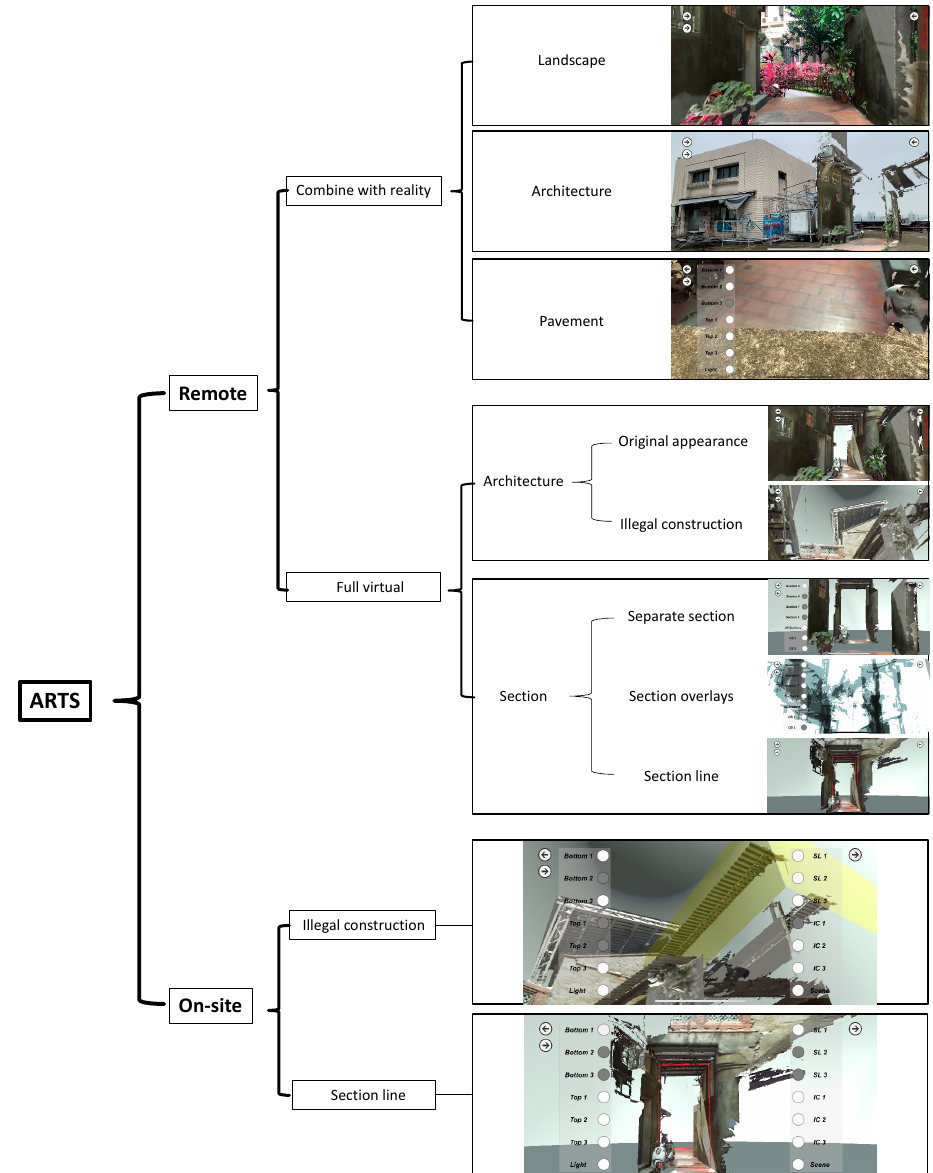
Figure 12. Augmented Reality tourism system (ARTS) system function structure diagram.